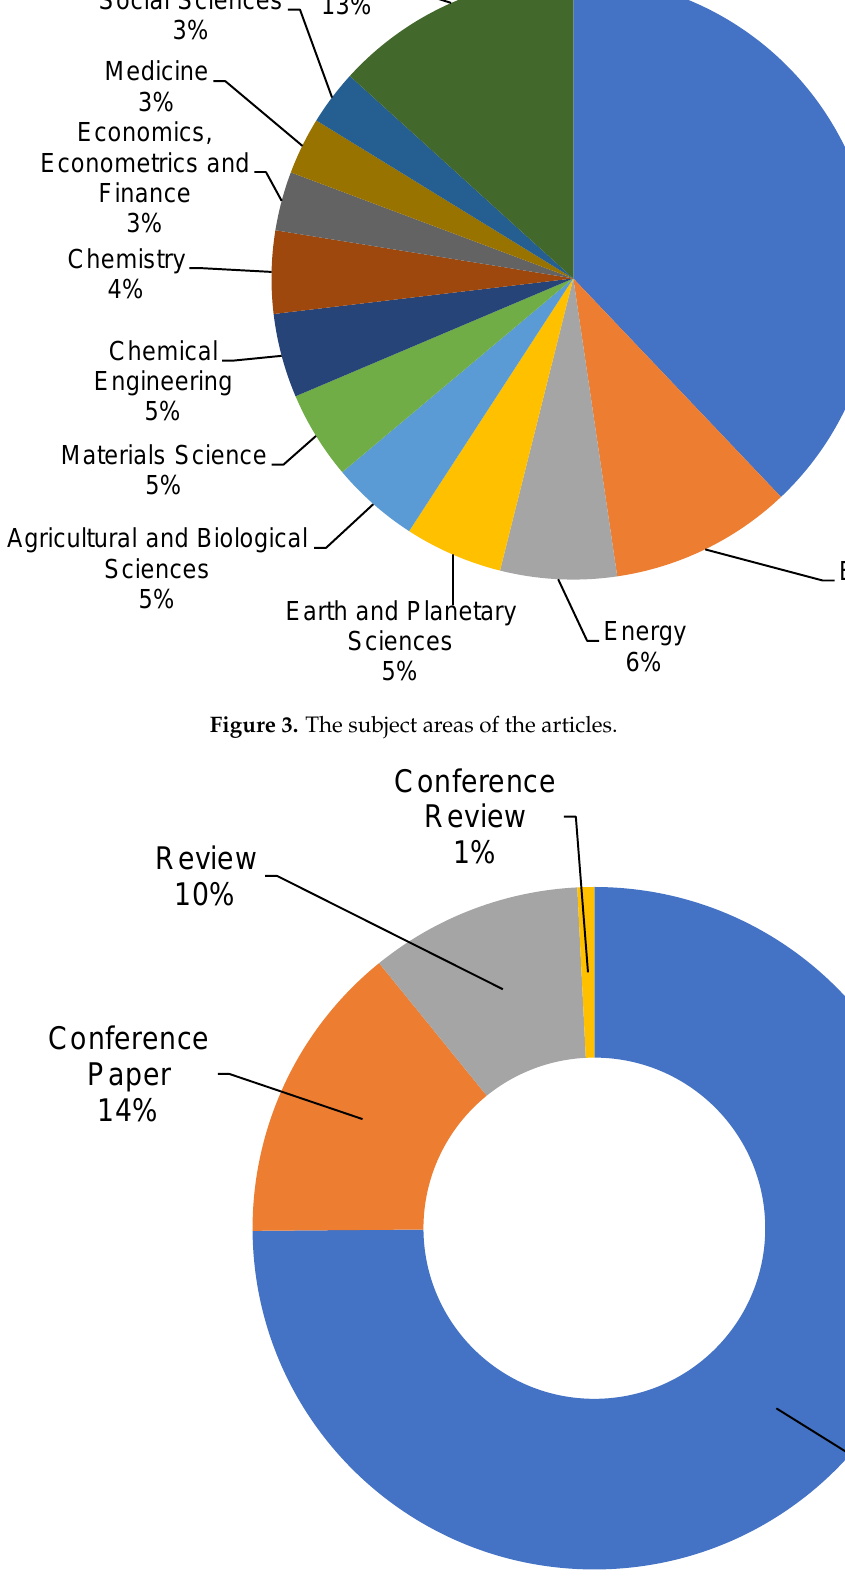
Figure 4. Various types of documents published in related fields of study.